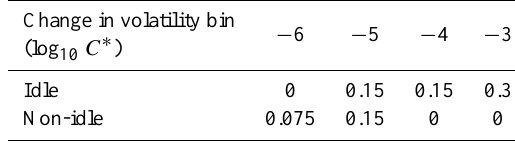
Table 1. Aircraft-specific mass yields for reactions of S/IVOC gas-phase species (NTSOA precursors) with OH. Values represent the mass transferred and the corresponding reduction in volatility (log 10 C ∗ ) for each oxidation step and are 1.5 times higher than the values reported by Jathar et al. (2012). For example, when re- acted with OH, 1g of NTSOA precursor from idle activities with a C ∗ value of 10 7 would produce 0.15g of SVOC with a C ∗ of 10 2 (7 − 5), 0.15g of SVOC with a C ∗ of 10 3 , and 0.3g of SVOC with a C ∗ of 10 4